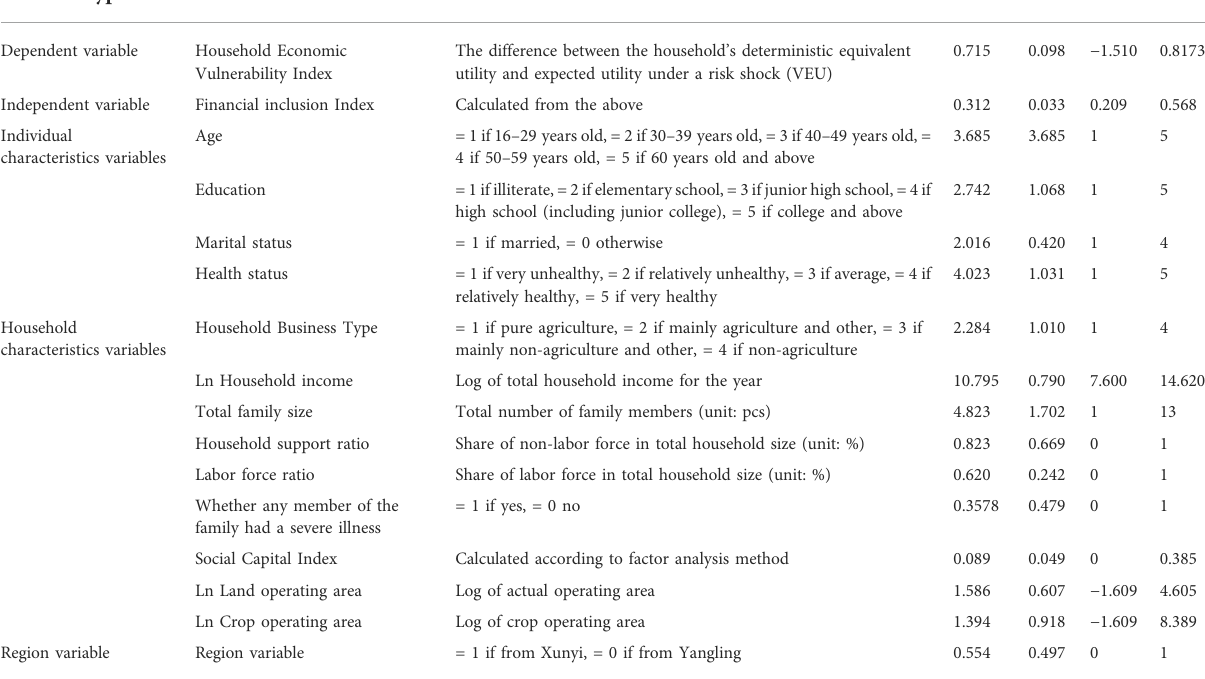
TABLE 2 De fi nition and summary of